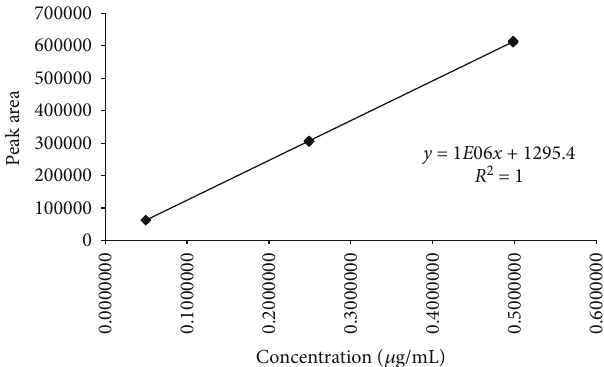
Figure 12: LOD and LOQ for ketorolac the degradation products. Table 7: Quanti fi cation results for ketorolac samples in wastewater. Conc. Sample